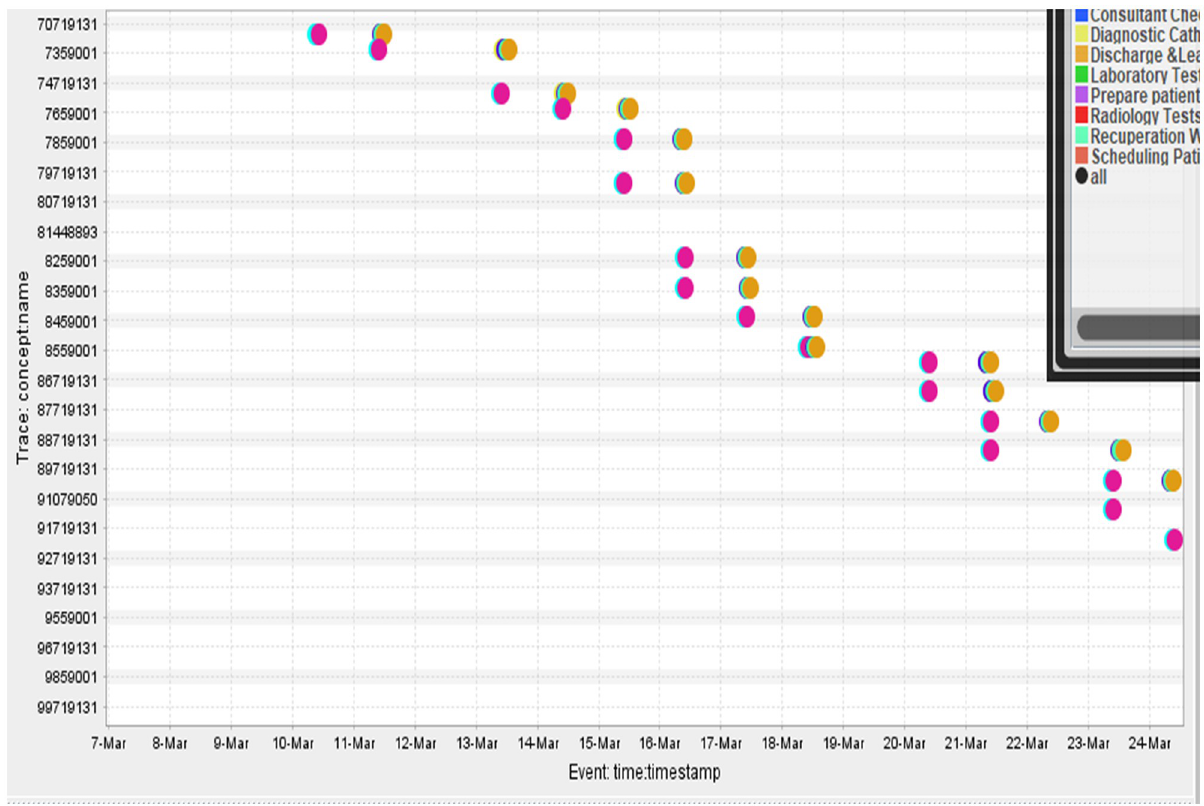
Fig 24. The dotted chart of cluster 1 of “cardiac stent and diagnostic catheterization”.